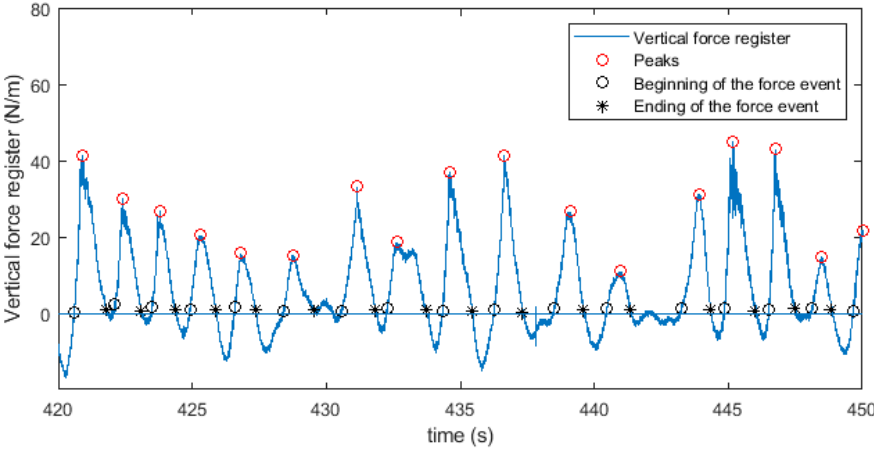
Figure 6. Example of determination of beginning, peak, and ending point for vertical forces of Test #10 on Crest wall A.